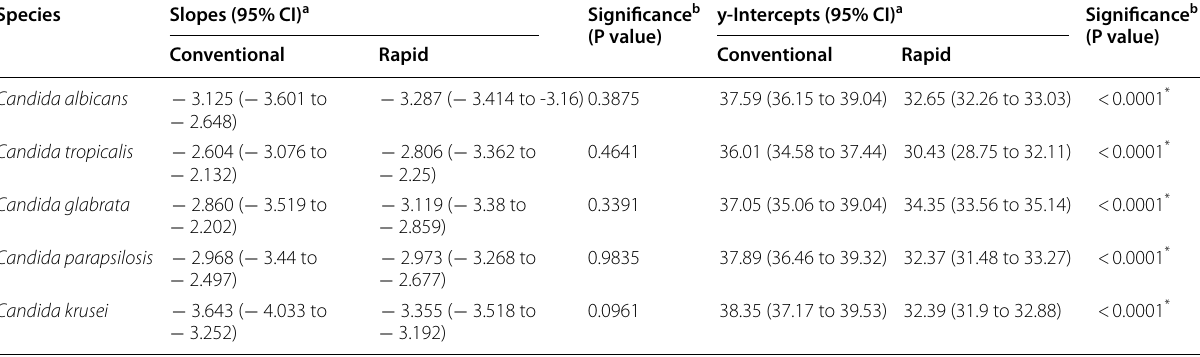
a The comparison was performed between two different DNA preparation methods, “conventional” here represents the conventional DNA preparation method, and “rapid” represents the rapid DNA preparation method we established b P values were calculated by default statistical method of the software GraphPad Prism 7.00 * Statistically significant (p <